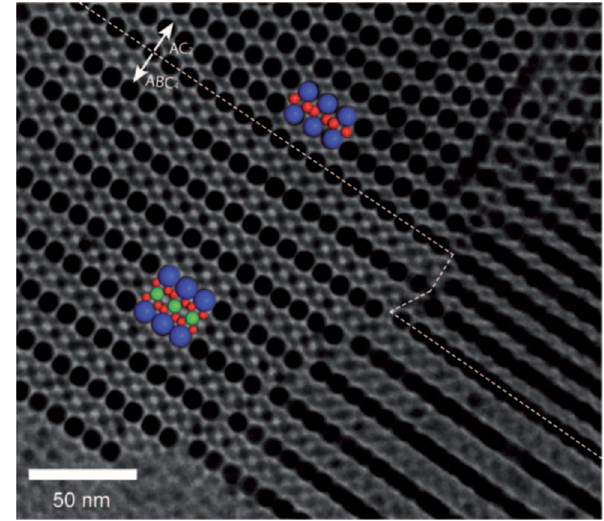
Figure 6. Transmission electron microscopy (TEM) image of the AlMgB 4 -type ternary superlattice (PbSe(l)-PbSe(m)-CdSe(s) 4 nanocrystal superlattice, l = large, m = medium, and s = small) in epitaxial contact with the AlB 2 -type binary superlattice (PbSe(l)-CdSe(s) 2 ). The TEM image and schematic show the (100) planes of the ternary superlattice, in which PbSe (l, blue spheres), PbSe (m, green spheres), and CdSe (s, red spheres) can be individually observed. (Reproduced with permission from [40]. Copyright John Wiley and Sons, 2009.